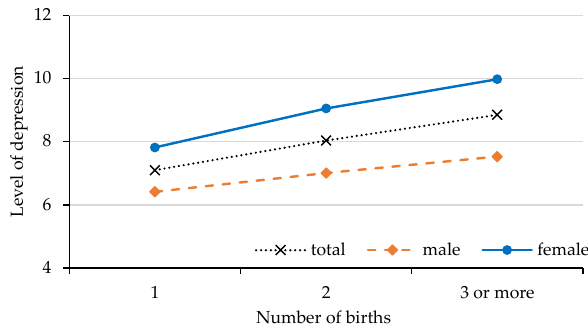
Figure 1. Number of births and depression in the elderly. Table 2. Number of births and depression.